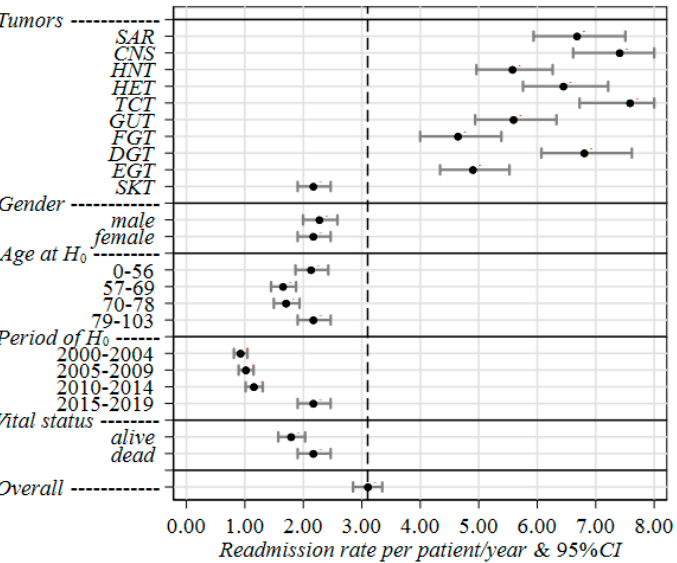
Figure 2. Joint effect of tumor group, gender, age at H 0 , period of H 0 and vital status at last discharge on readmission rates of rare tumors patients in Liguria Region during 2000–2019, estimated through the multivariable negative-binomial regression method. Legend—H 0 : index hospitalization (first admission); Rate: readmission rate per patient/year; 95% CI: 95% confidence interval; SAR: sarco- mas; CNS: central nervous system; HNT: epithelial tumors of head and neck; HET: hematological malignancies; TCT: epithelial tumor of thoracic cavity; GUT: urinary system and male genital or- gans; FGT: female genital system; DGT: epithelial tumor of digestive system; EGT: tumor of endo- crine glands; SKT: epithelial tumor of